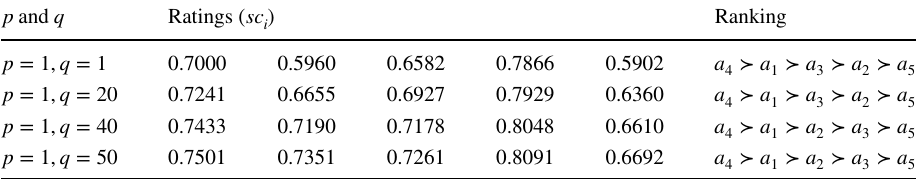
p and q Ratings ( sc